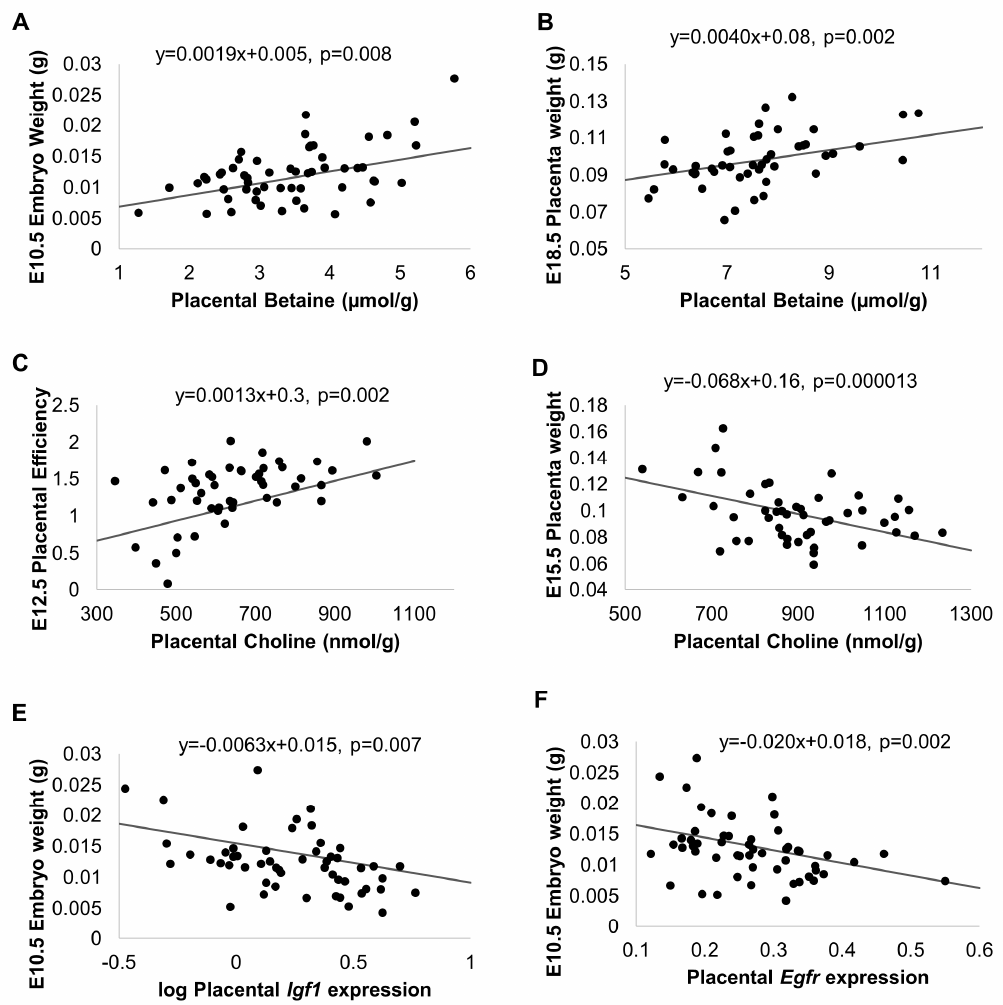
Figure 3. Relationships between placental choline metabolites, placental gene expression, and fetal